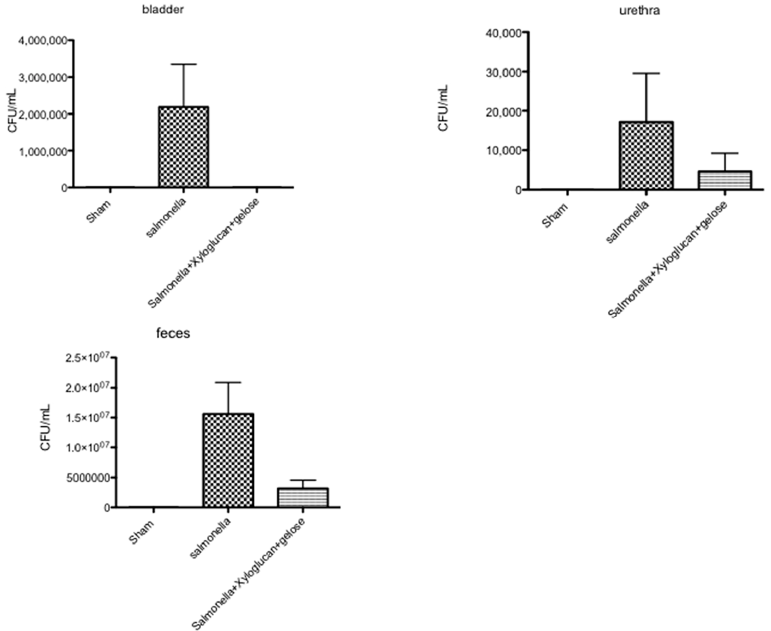
Figure 7. The number of bacteria recovered from bladder, urethra, and feces of rats killed eight days after S. enterica inoculation . Seven days after S. enterica inoculation, all rats had positive bladder and urethra cultures (bladder and urethra graphs). The number of bacteria recovered from the bladder showed a tendency to decrease in both the bladder and urethra after xyloglucan + gelose treatment (bladder and urethra graphs). S. enterica was significantly eliminated from the urinary tract but not from feces following xyloglucan + gelose treatments (feces graphs). Figures are representative of at least three separate experiments. Values are means ± SEM of 10 animals for each